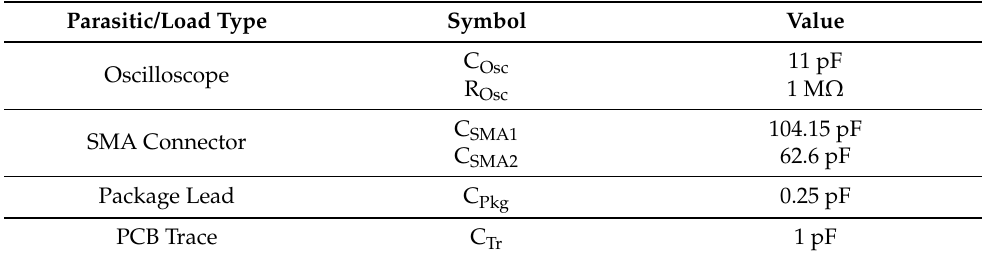
Table 1. Loading and Parasitic Capacitances.